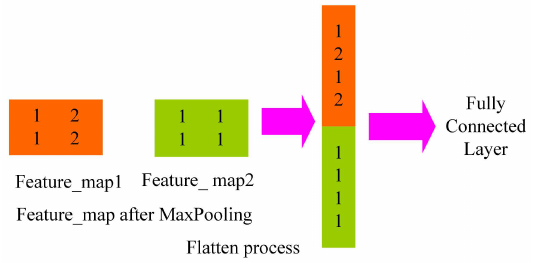
Figure 9. Image feature “flatten”